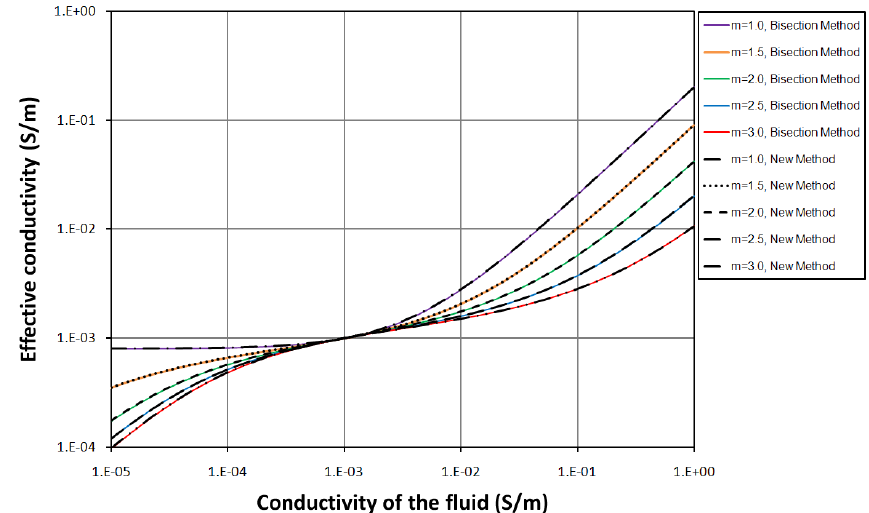
Fig. 3. Effective electrical conductivity σ eff calculated using the Bussian equation as a function of porosity at 1001 points for both the bisection method and the conformal mapping method ( φ =0.2; m =1, 1.5, 2, 2.5, 3; σ m =10 − 3 S/m; 10 − 5 S/m ≤ σ f ≤ 1S/m). Note that the bisection method and the conformal mapping method are indistinguishable for all values of φ , m , σ m , σ f used: A graph of one versus the other is a 1:1 straight line.